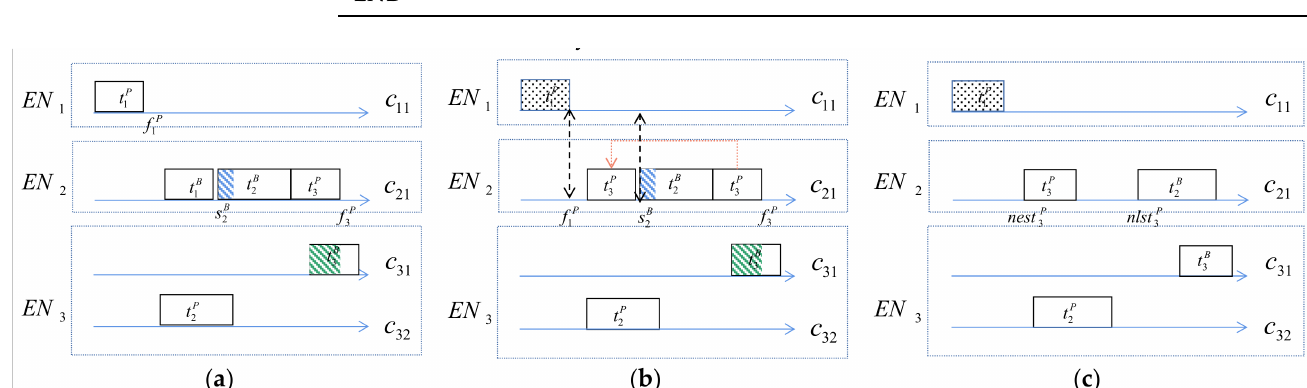
(cid:0) (cid:1) t B is changed 2